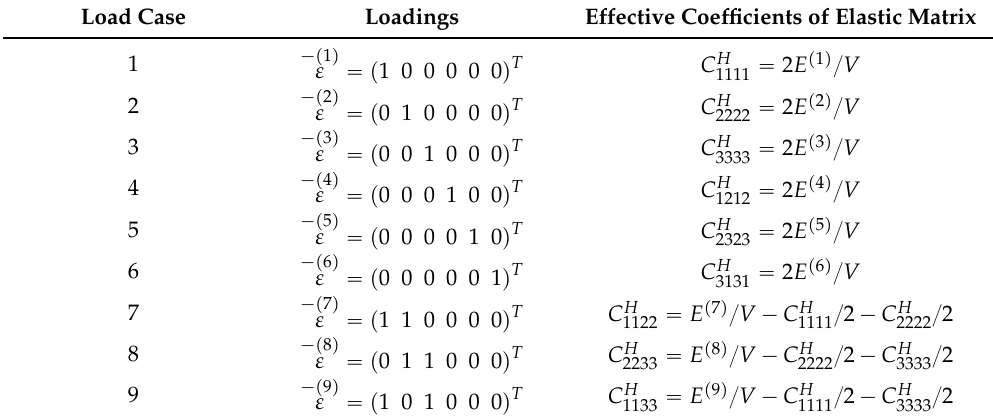
Table 1. Different loadings and the coefficients of elastic